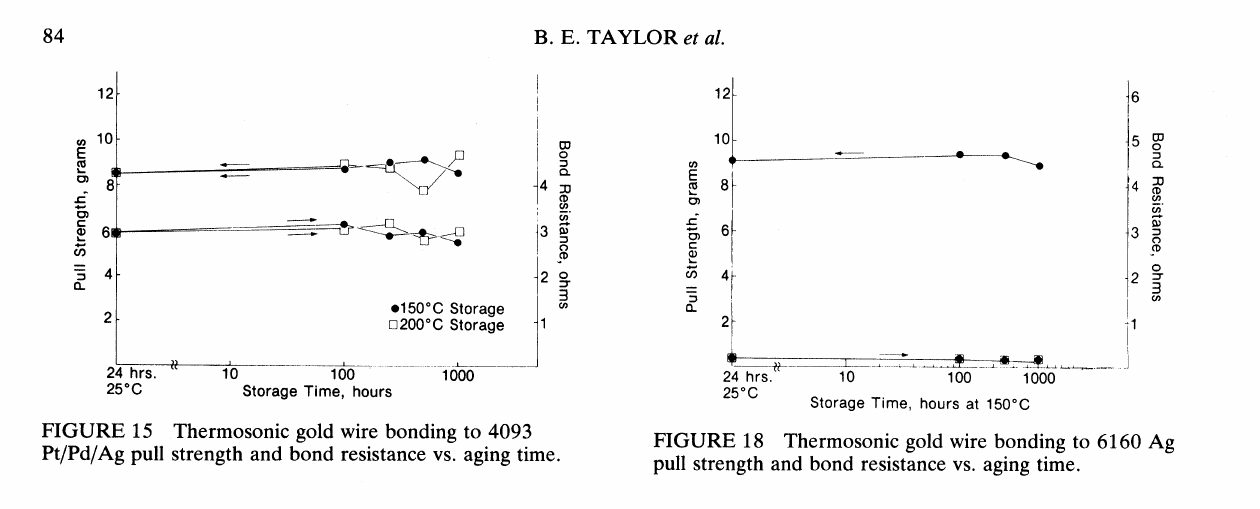
FIGURE 18 Thermosonic gold wire bonding to 6160 Ag pull strength and bond resistance vs. aging time. TABLE XIV Ultrasonic aluminum-wire bond results.